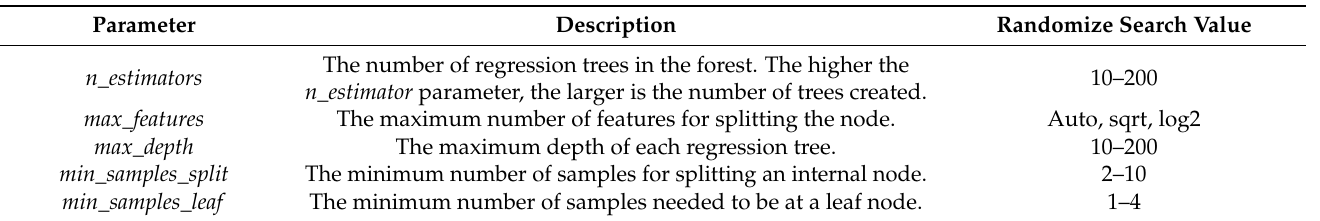
Table 2. Summary of hyperparameter for Random Forest-Adaboost regression